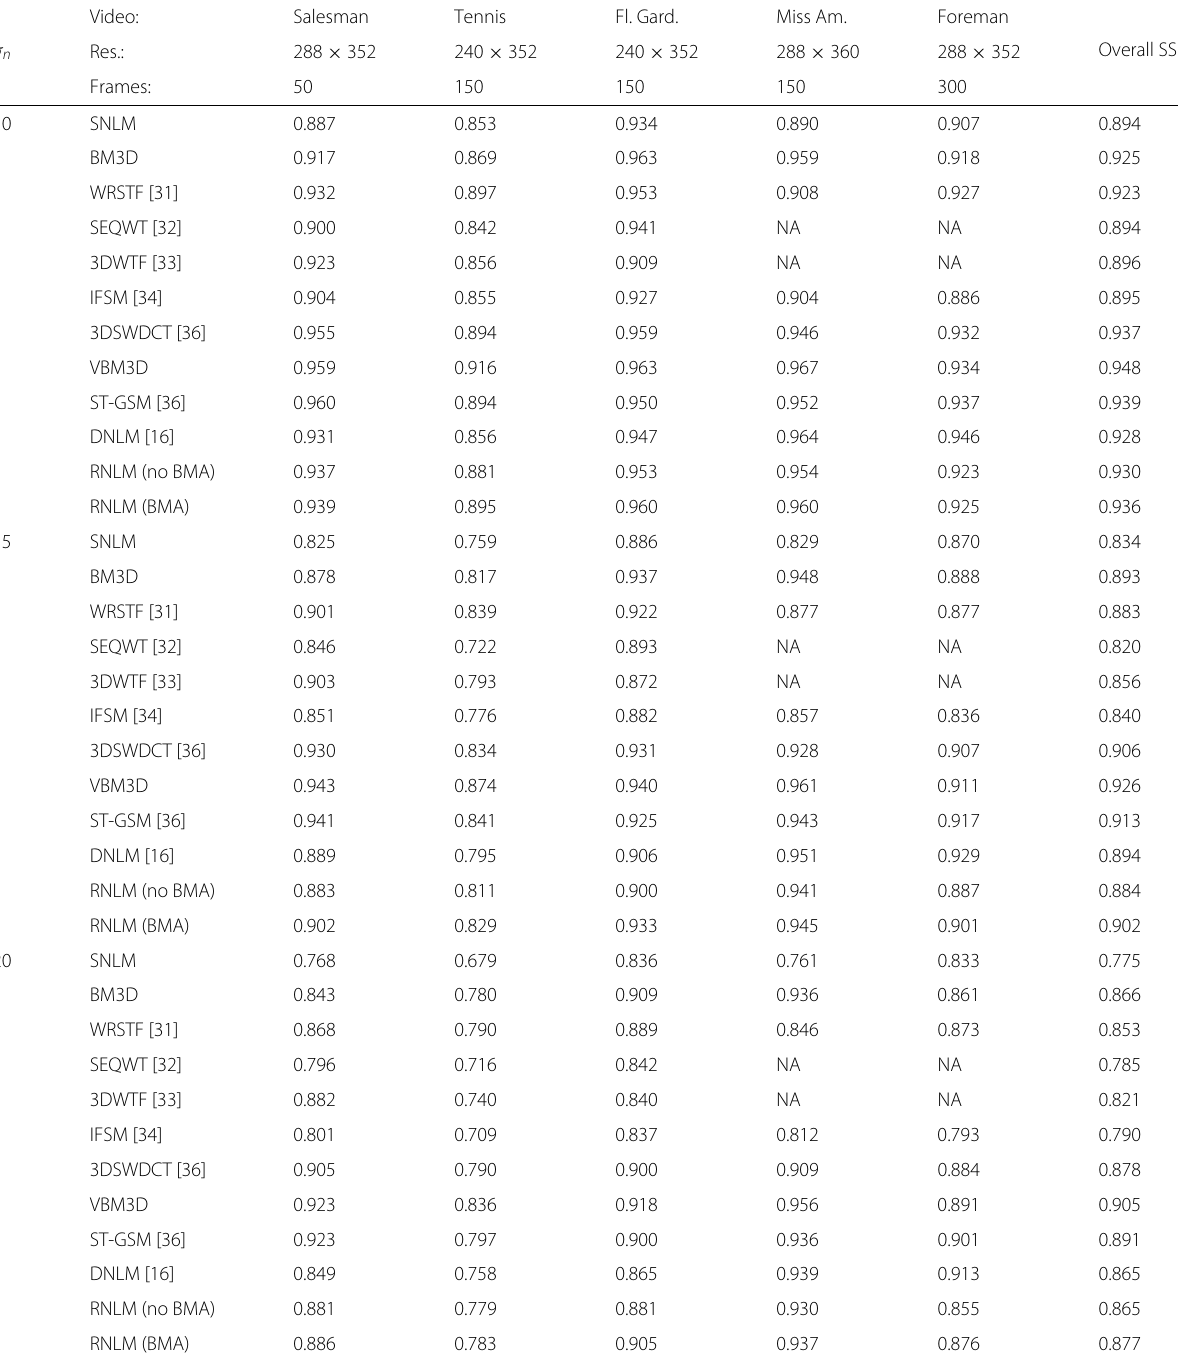
Table 3 SSIM comparison with published results for several competitive denoising algorithms using five different sequences and three noise standard deviation